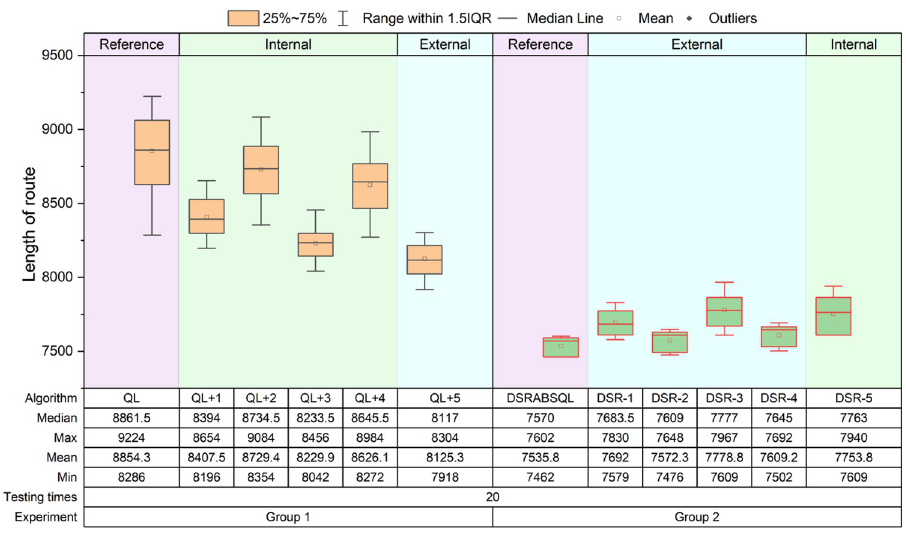
Fig 13. Boxplots obtained by testing rat575 for 20 times by each algorithm.